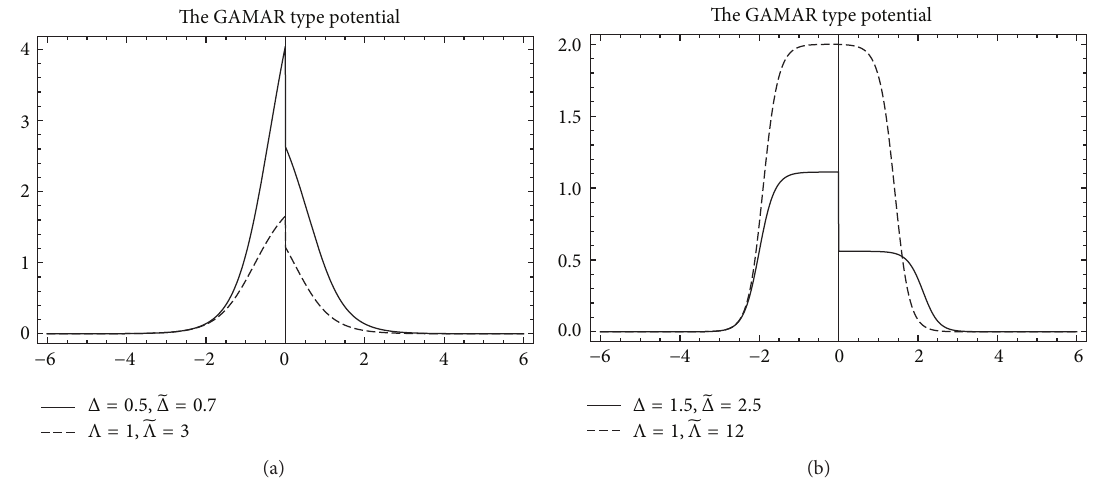
Figure 1: The shapes of the GAMAR type potential for different values of the potential parameters. (a) shows 𝛼 = 𝛽 = 2 , 𝑥 0 = ̃𝑥 0 = 1 , and 𝐴 = 𝐵 = 𝐶 = 𝐷 = 1 (lower values of the 𝛼𝑥